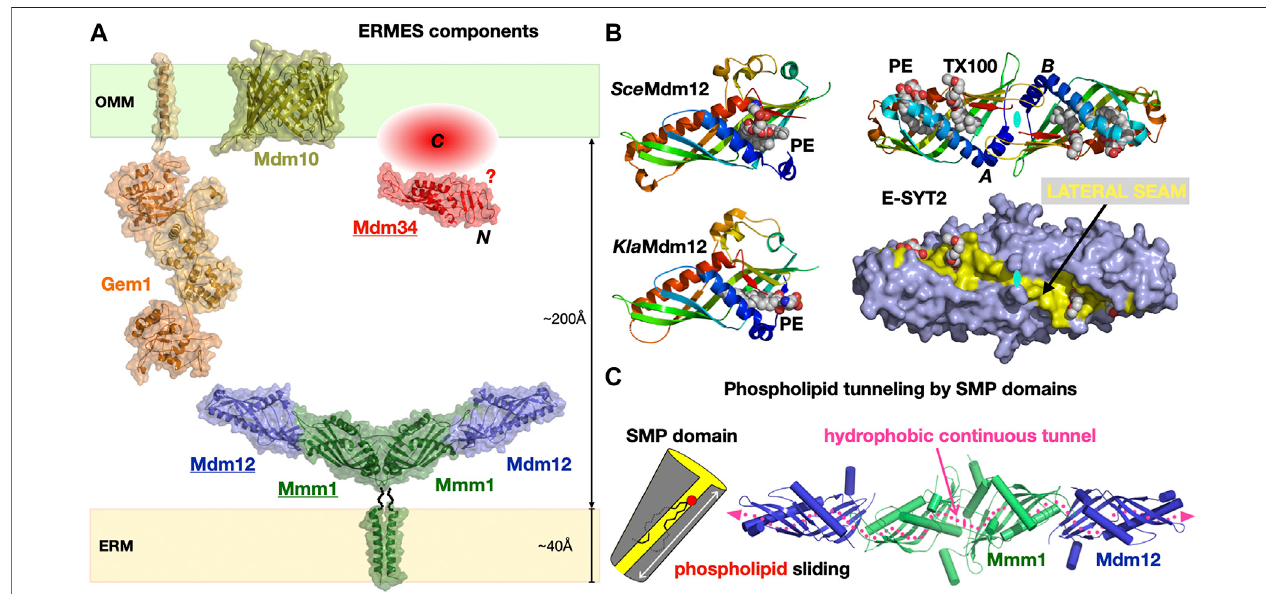
FIGURE6| TheEndoplasmicReticulum-to-MitochondrionEncounterStructure. (A) CompositestructuralmodeloftheyeastERMESincludingthestructuresofthe Mdm12/Mmm1 heterotetrameric core of SMP domains and the Mmd10 porin and combining the homology models of the Gem1 Miro GTPase and the Mdm34 SMP domaingeneratedin Phyre 2 .TheC-terminaldomainofMdm34isrepresentedasanunstructuredmodule. (B) StructuresofdiverseSMPdomains-Mdm12( S.cerevisiae and K. lactis ) and dimer of E-SYT2- showing the different positions sampled by bound PLs along the lateral seam of the SMP domain; the E-SYT2 dimer is represented using ribbon and also full surface (slate blue) representations to emphasize the existence of a lateral seam (yellow). PL ligands are shown as spheres; in E-SYT2 an additional molecule of Triton X100 detergent was observed. All structures are shown under the same orientation relative to E-SYT2 monomer A. (C) Hydrophobic tunnel spanning the entire length of the Mdm12/Mmm1 tetrameric assembly of aligned SMP domains for the sliding of PLs along the solvent-accessible lateral seam (magenta dotted line) exposing the polar headgroups of the PLs (PDB 5GYD-5H5A-4P42-5YK7).